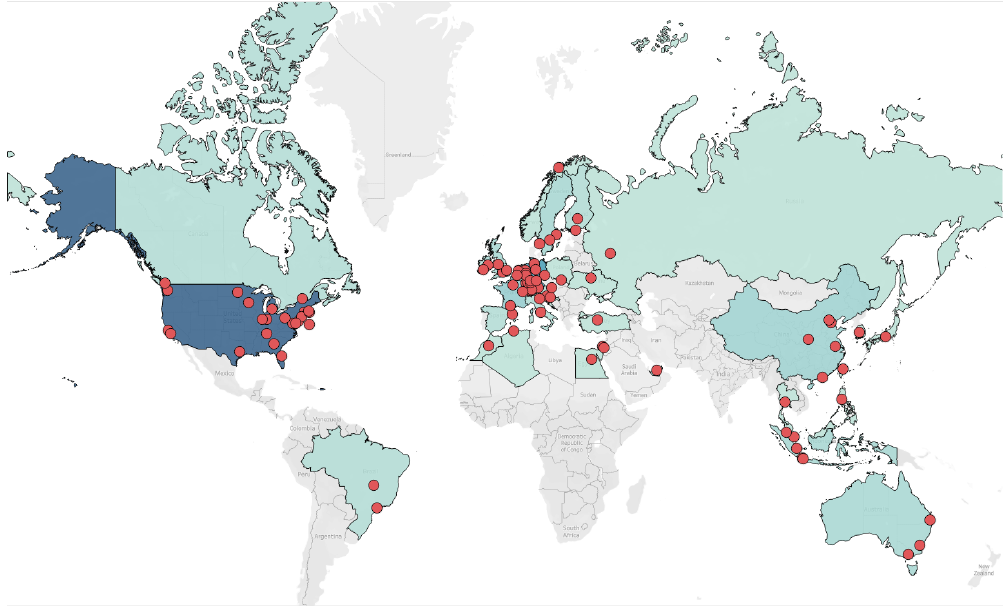
Figure 3. Map of academic research institutions with data access rights granted in